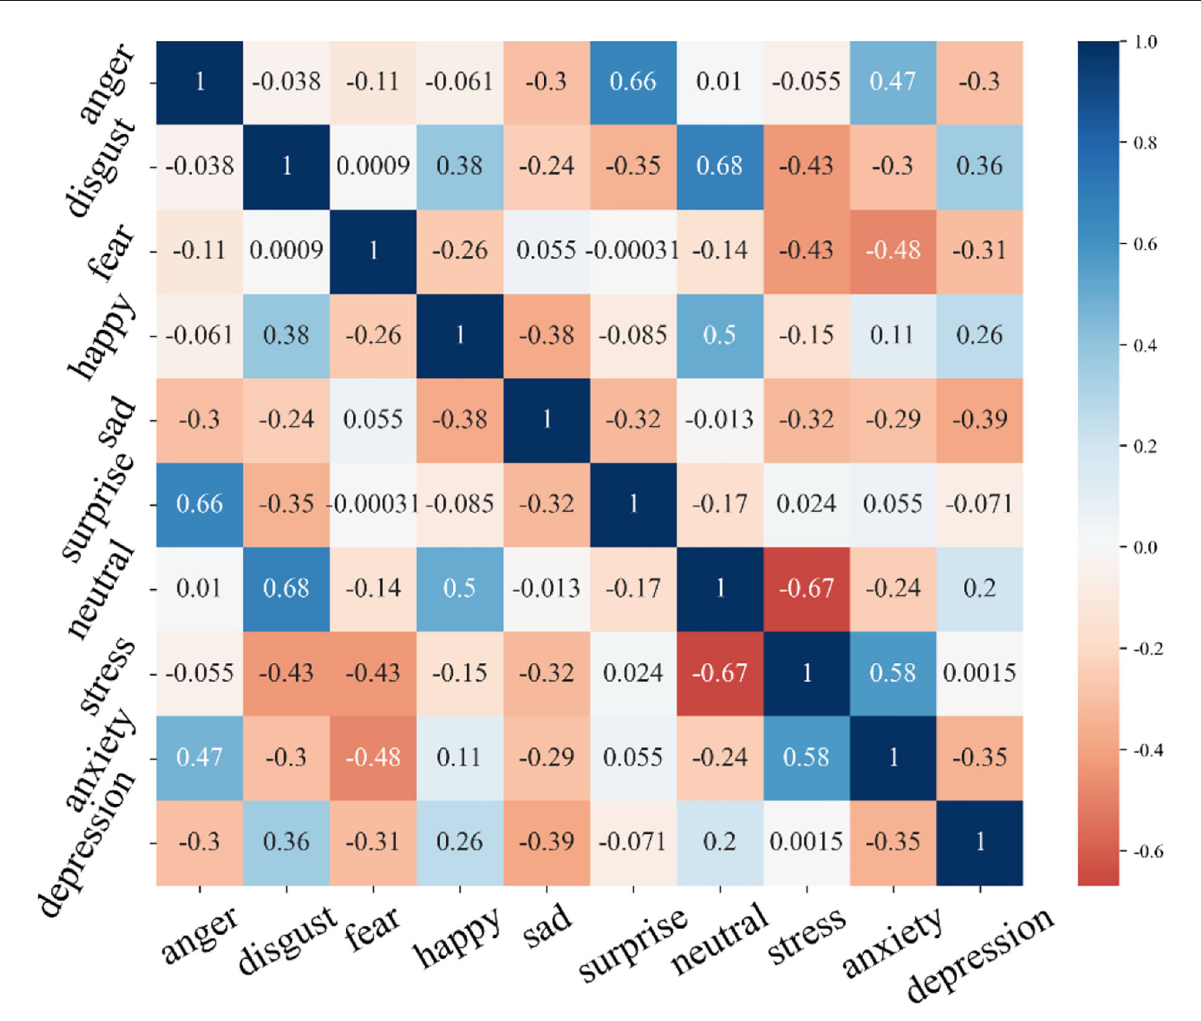
FIGURE4 The multitrait-multimethod matrix involved a zero-order correlation matrix between six trait